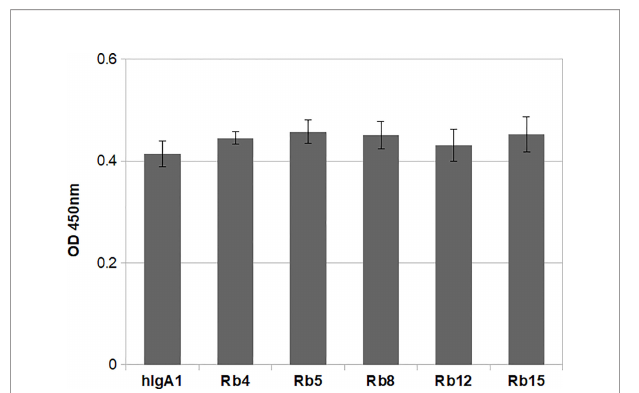
FIGURE 5 | Stimulation of neutrophil-mediated chemiluminescence by hIgA1 and the rabbit hinge hybrids attached to NIP-BSA-coated microtiter plates. Respiratory bursts were induced by the immunoglobulins at 100 m g/ml. A negative control lacking IgA (neg) is also shown. Each point shown is the mean of triplicate determinations. Relative light units (RLU) per second were plotted against time. The experiment was performed twice with the results shown representing a typical